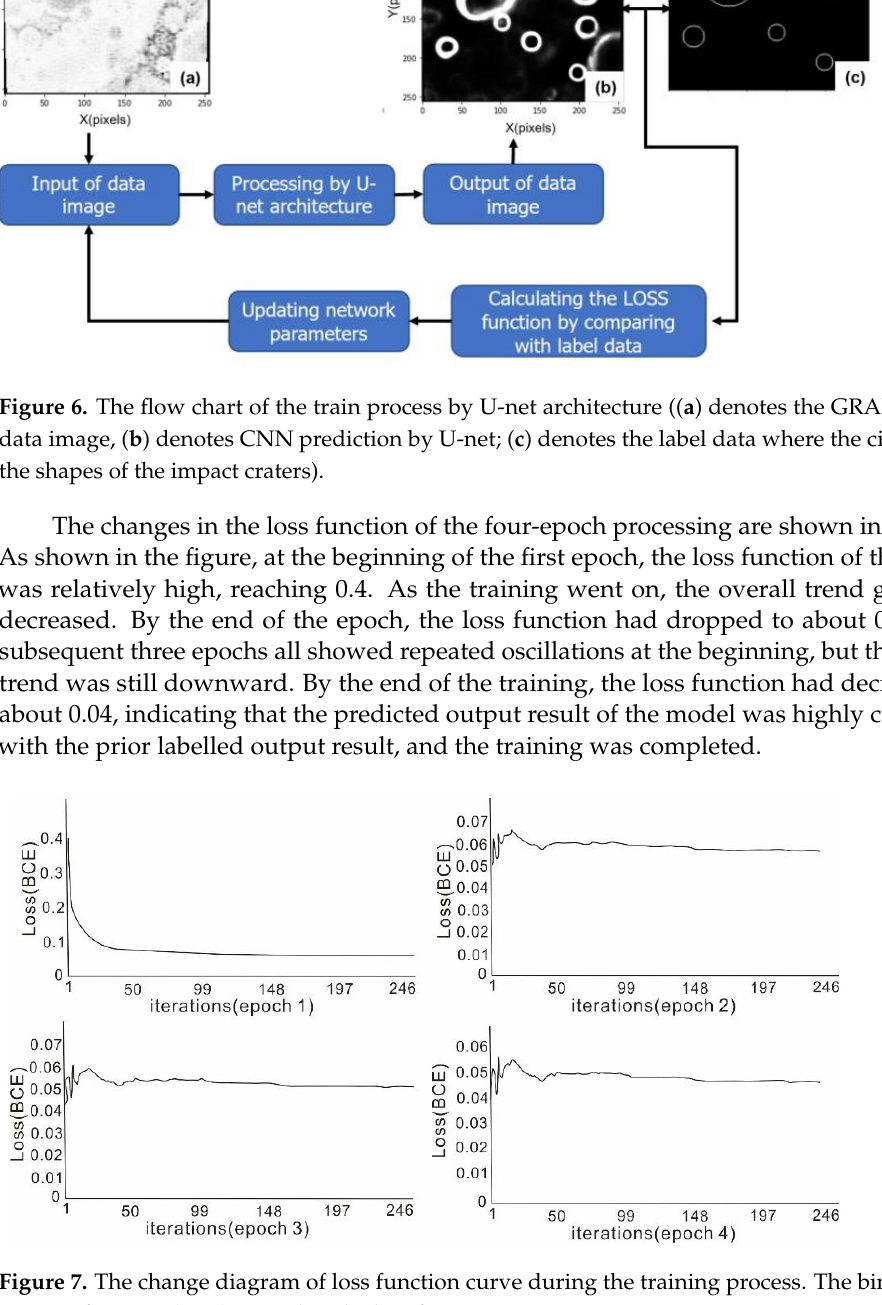
Figure 7. The change diagram of loss function curve during the training process. The binary-cross entropy function (BCE) is used as the loss function.